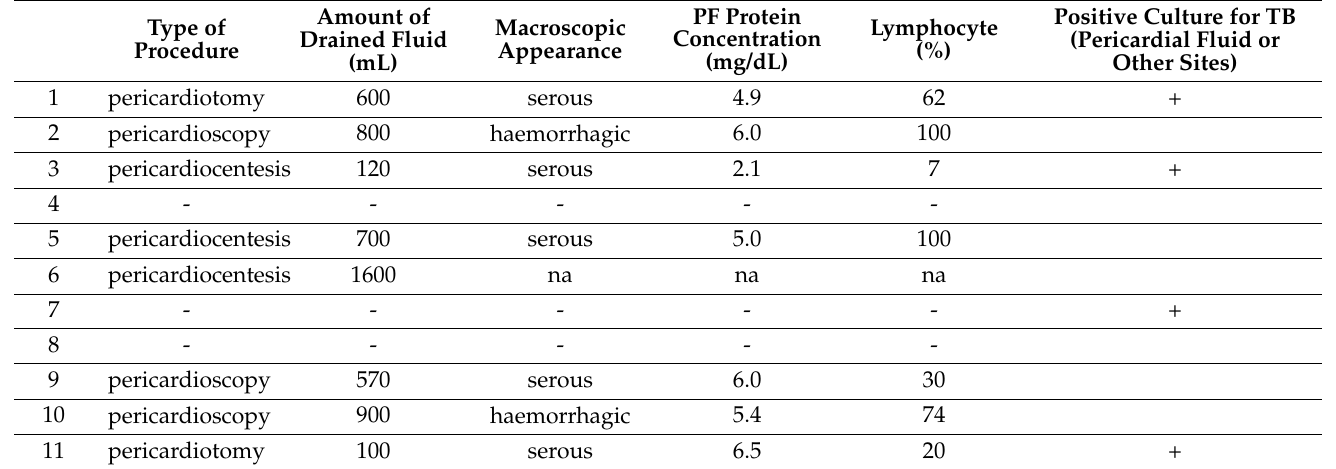
Table 2. Results of invasive procedures performed in patients diagnosed with tuberculous